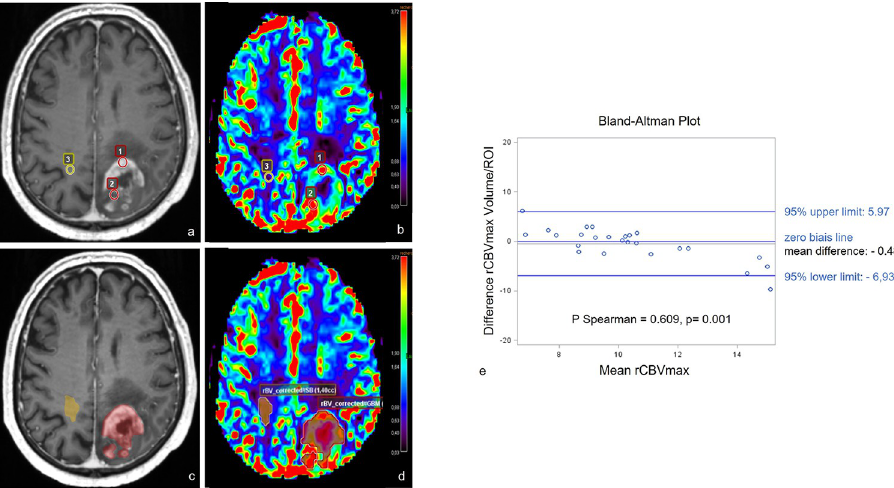
Fig 2. Illustration of the two different methods. Two methods were used to calculate the maximum relative cerebral blood volume (rCBVmax) and %rCBV > 2, in a 60-year-old patient with glioblastoma. a) and c) axial contrast- enhanced T1-weighted images; b) and d) corrected rCBV maps. Top line, the hot-spot method: Two ROIs (red) are placed in hypervascularized areas of the enhancing tumour and one (yellow) is placed in the contralateral white matter for normalization. Bottom line, the volume method: Segmentation of the enhancing tumour (red) slice by slice including areas of high and low neoangiogenesis and segmentation of a volume of interest in the contralateral white matter (yellow) for normalization. e) The Bland-Altmann plot illustrates the concordance between the two methods used to analyse